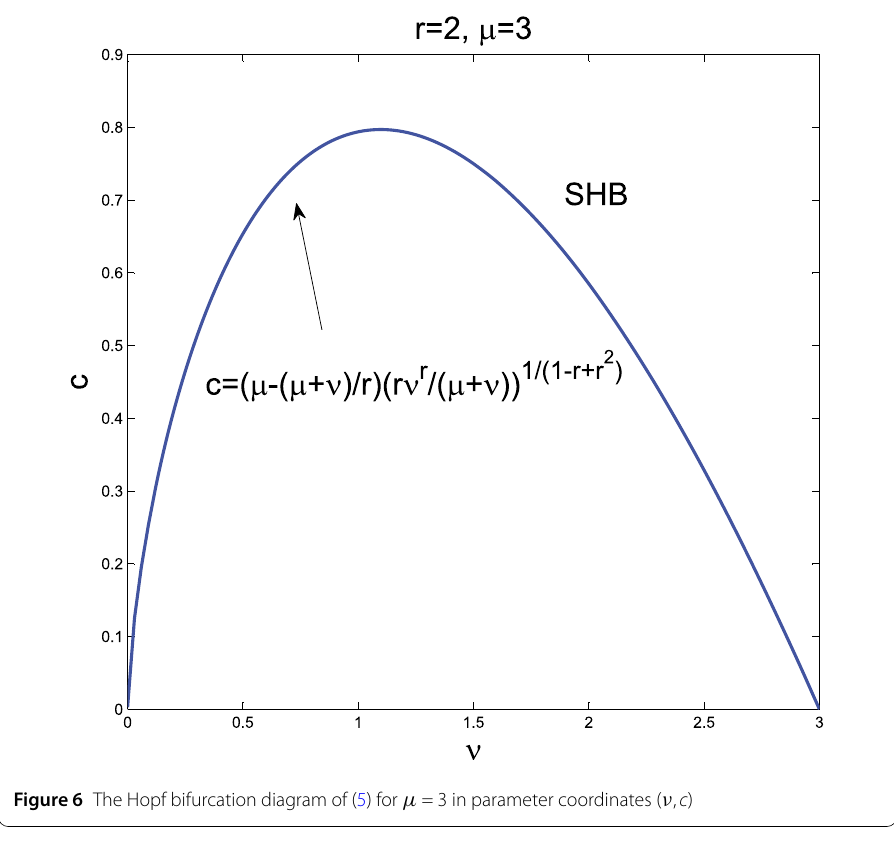
Figure 6 The Hopf bifurcation diagram of (5) for μ = 3 in parameter coordinates ( ν , c )